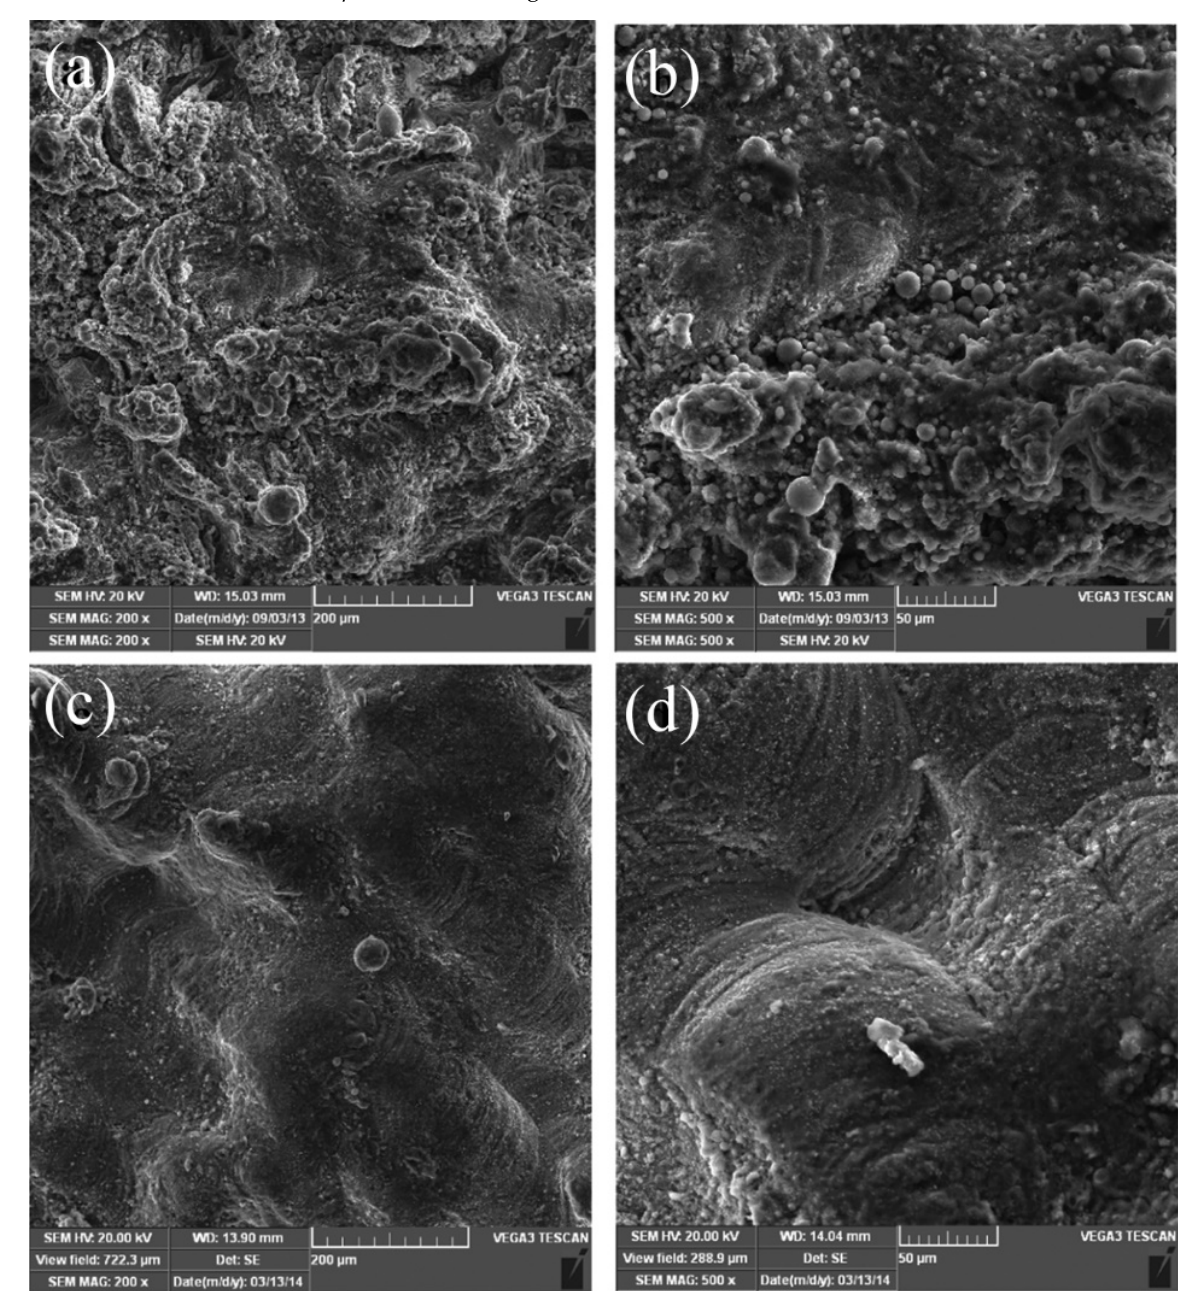
Figure 2. SEM topology under different magnifications of specimens fabricated using magnesium powders with granularity of ( a , b ) 400 mesh and ( c , d ) 250 mesh. Reprinted with permission from ref. [36]. Copyright 2015 Taylor and Francis Group.